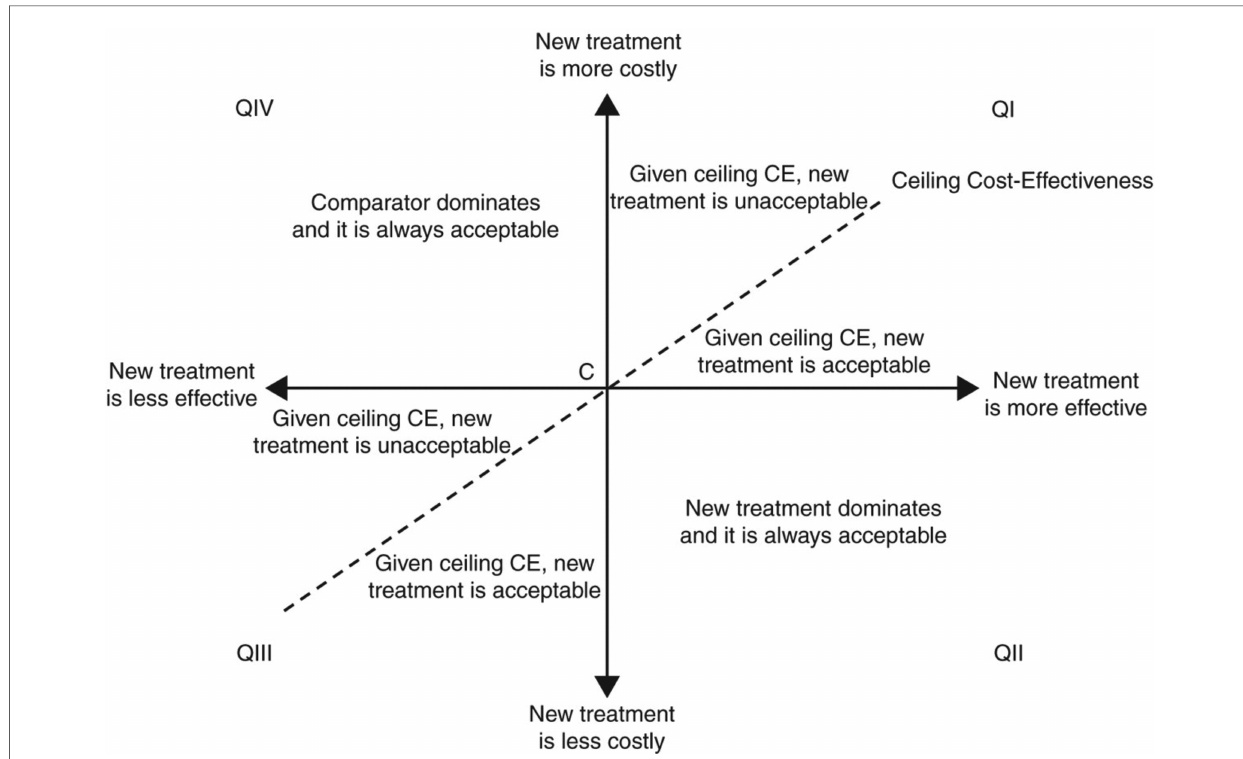
FIGURE 1 Cost-effectiveness plane. The horizontal axis represents the difference in bene fi ts between the two therapies (e.g., difference in quality-adjusted life expectancy) and the vertical axis represents the difference in the cost. Quadrant II of the plane represents a situation where a new treatment “ dominates ” or is always acceptable than the comparator treatment; it re fl ects a situation where the new therapy is less costly and more effective. The opposite occurs in Quadrant IV, where the existing therapy dominates the new treatment. Quadrant I is where a new therapy is both more effective and most costly. If the incremental bene fi ts are attained for acceptable incremental costs (this relationship is represented by the slope of the dotted line), then the new treatment is acceptable. [Reproduced from EP Europace 2011; 13(Suppl_2):ii3 – ii8 with permission].